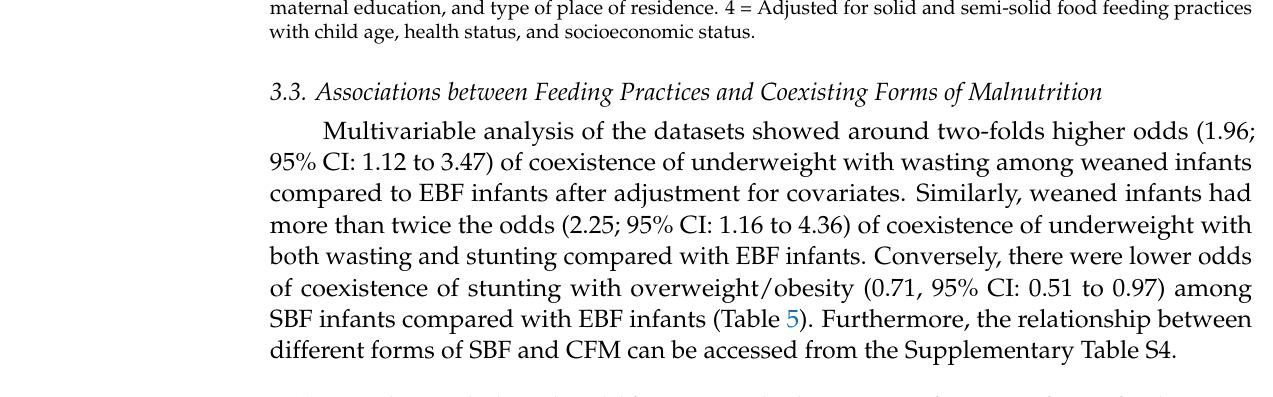
Table 5. Multinomial adjusted model for assessing the determinants of coexisting forms of